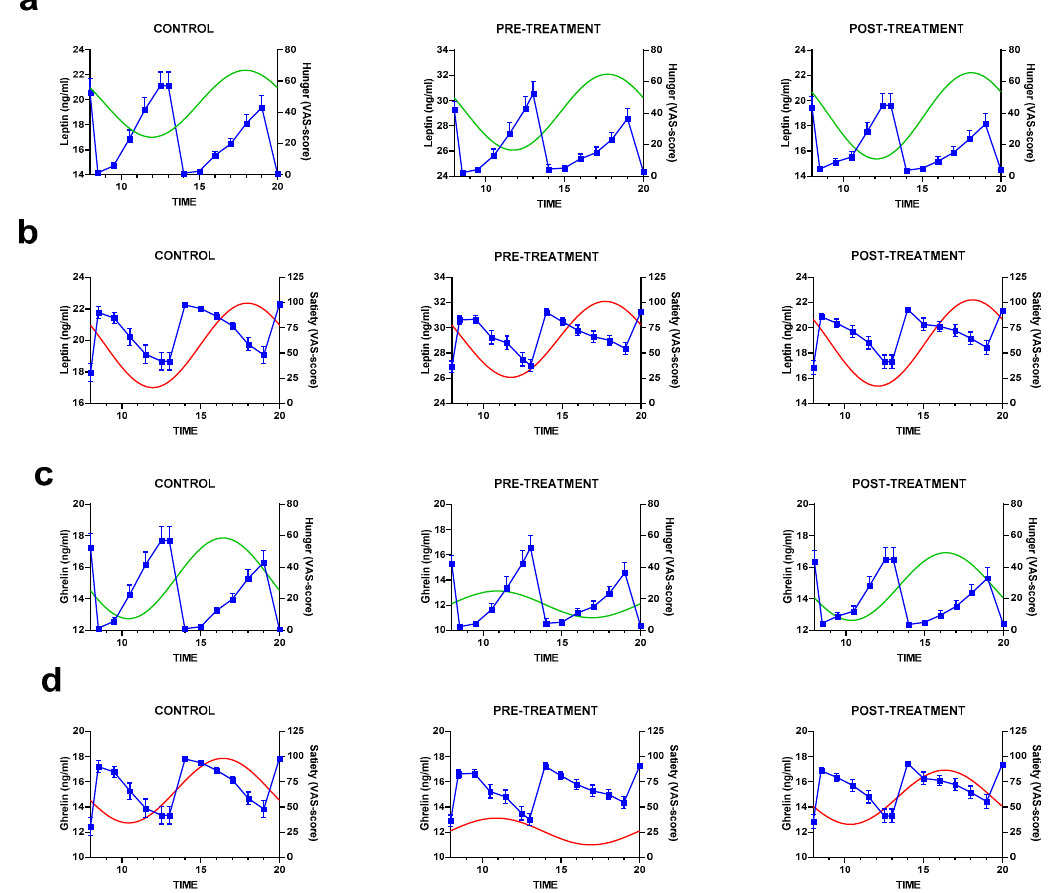
Figure 5. Overlaid cosinor fitted curve (left y -axis) and appetite sensations (right x -axis) for ( a ) leptin and hunger, ( b ) leptin and satiety, ( c ) ghrelin and hunger, and ( d ) and ghrelin and satiety. Hunger and satiety scores represent the mean ± SEM. Green and red lines represent leptin and ghrelin cosinor fitted curve of every group (control, pre- and post-treatment).